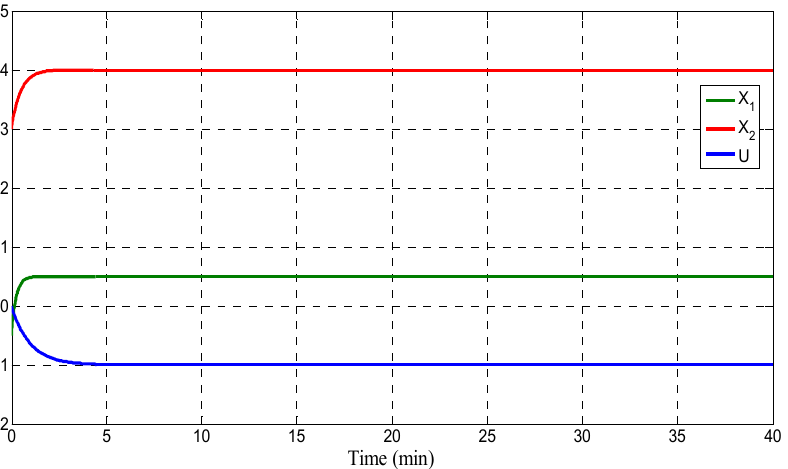
Figure 4. Dynamic of the CSTR state variables in the occurrence of the unmeasured disturbance D 2 . To better interpret the problem, let a random disturbance be injected into the CSTR model. This later disturbance was considered for the process simulation, nonetheless, ignored in the CSTR control model calculation.